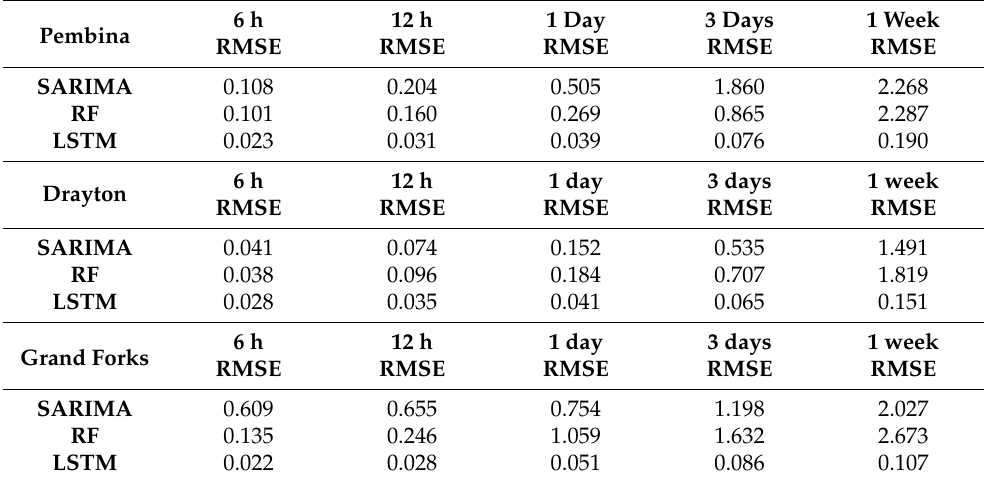
Table 2. Evaluation of the performance of SARIMA, RF, and LSTM models at three USGS stations root mean square error (RMSE between the predicted and observed water-level data in the testing